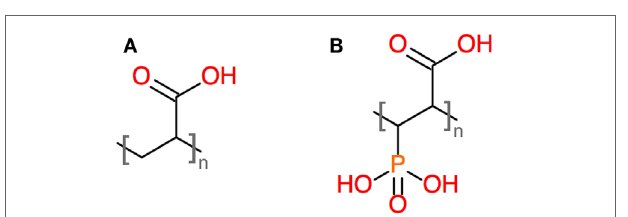
FigUre 8 | structures of repeating units of (a) Paa and (B) a copolymer of acrylic acid and vinylphosphonic acid .